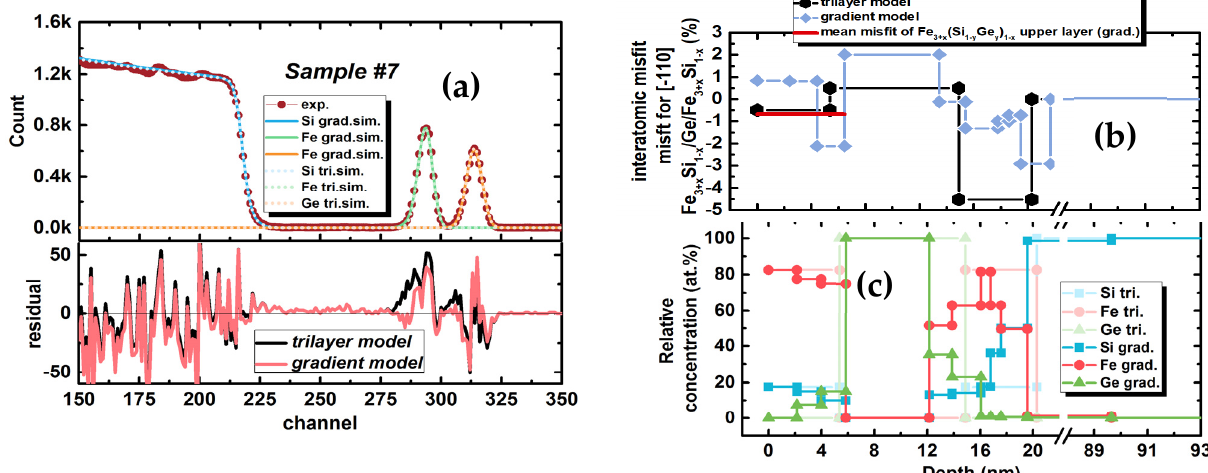
Figure 5. RBS spectra for Fe 3+ x Si 1 − x /Ge/Fe 3+ x Si 1 − x /Si(111) (sample #7) ( a ), misfits of each layer calculated based on the different fitting model of RBS spectra ( b ), a profile of relative chemical element concentration (at.%) derived from the RBS measurements for gradient and trilayer model ( c ).